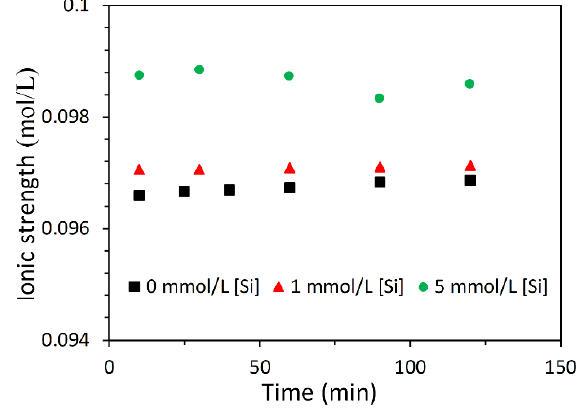
Figure 4. Ionic strength of solution.